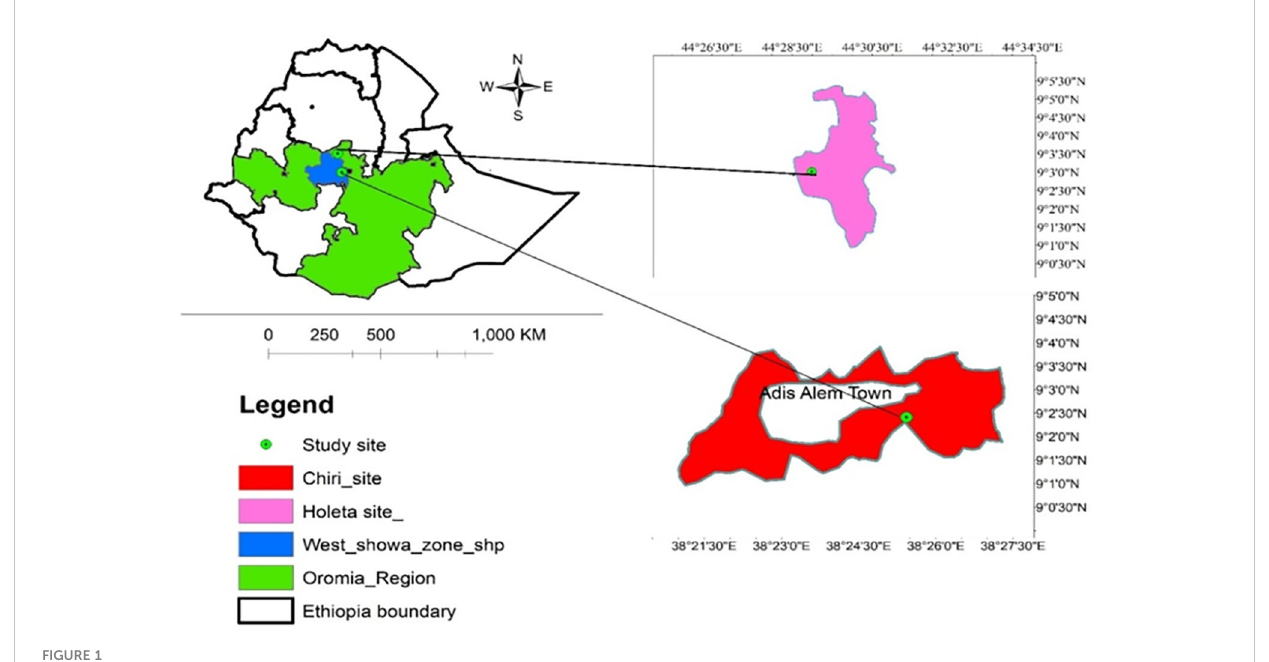
FIGURE 1 Map of the study